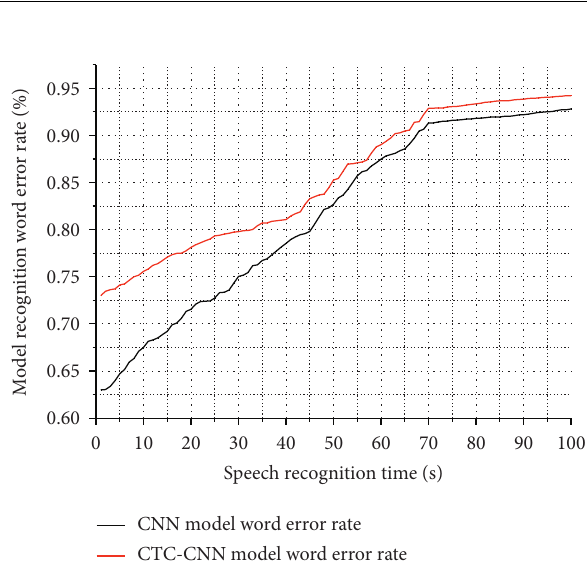
Figure 3: The acoustic model word error